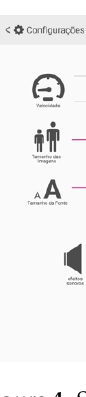
Figure 4. Setup screen. Figure 4. Setup